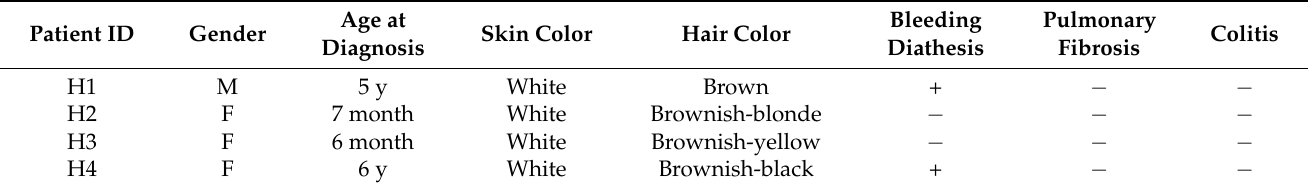
Table 1. Demographics and clinical findings of the HPS